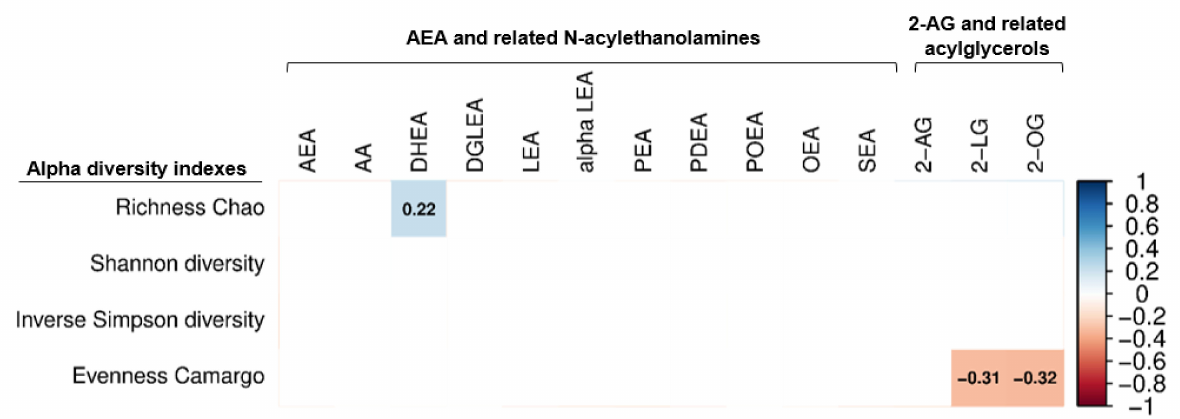
Figure 1. Partial Spearman correlations of plasma levels of endocannabinoids and their analogues with fecal microbiota alpha diversity indexes. Boxes only represent the statistically significant ( p < 0.05) correlations and the value within the boxes show the spearman correlation coefficient. Blue boxes indicate positive correlations, whereas red boxes indicate negatives correlation. Body mass index was included as confounder in these correlations. 2-AG: 2-arachidonylglycerol; 2-LG: